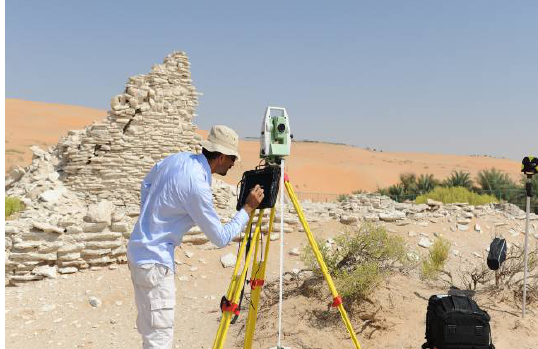
Figure 9. Monitoring survey of a major crack with total station at Om Hosn site in Liwa.